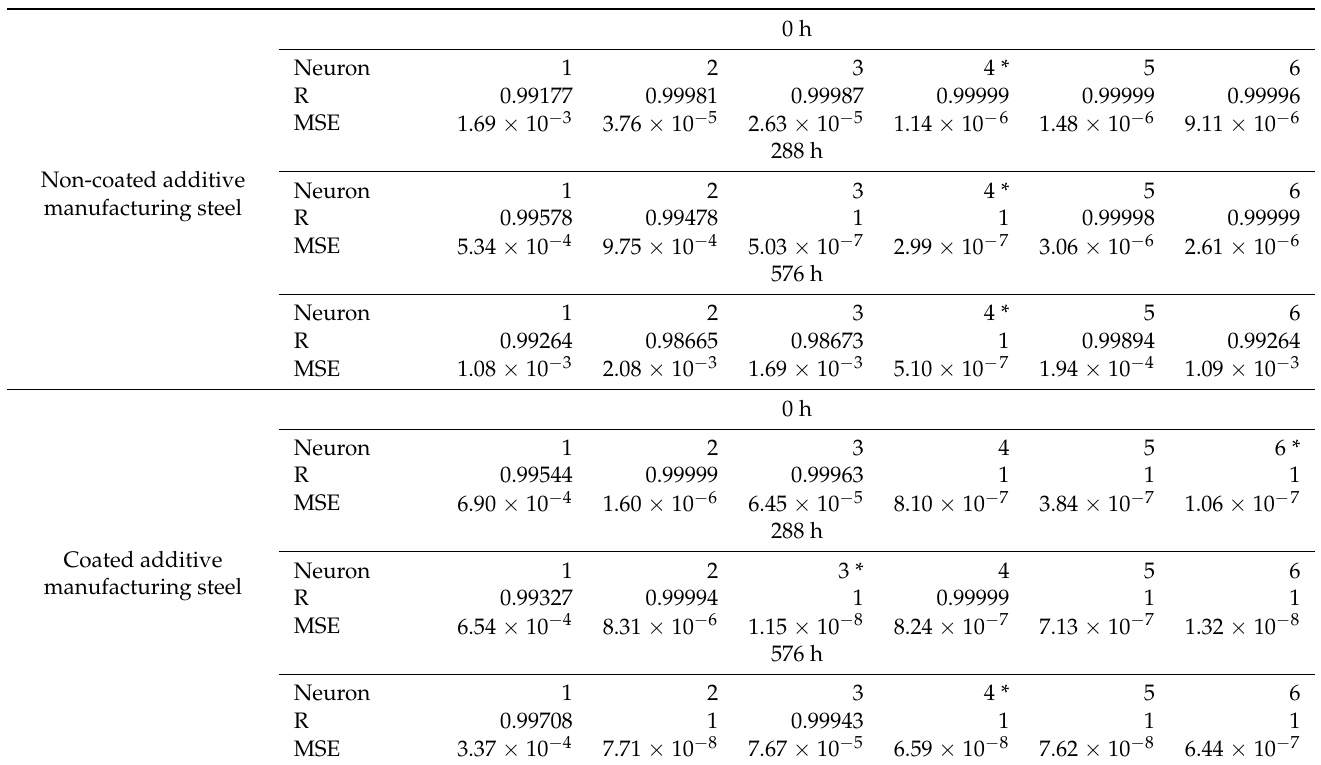
Table 1. Selection of the best